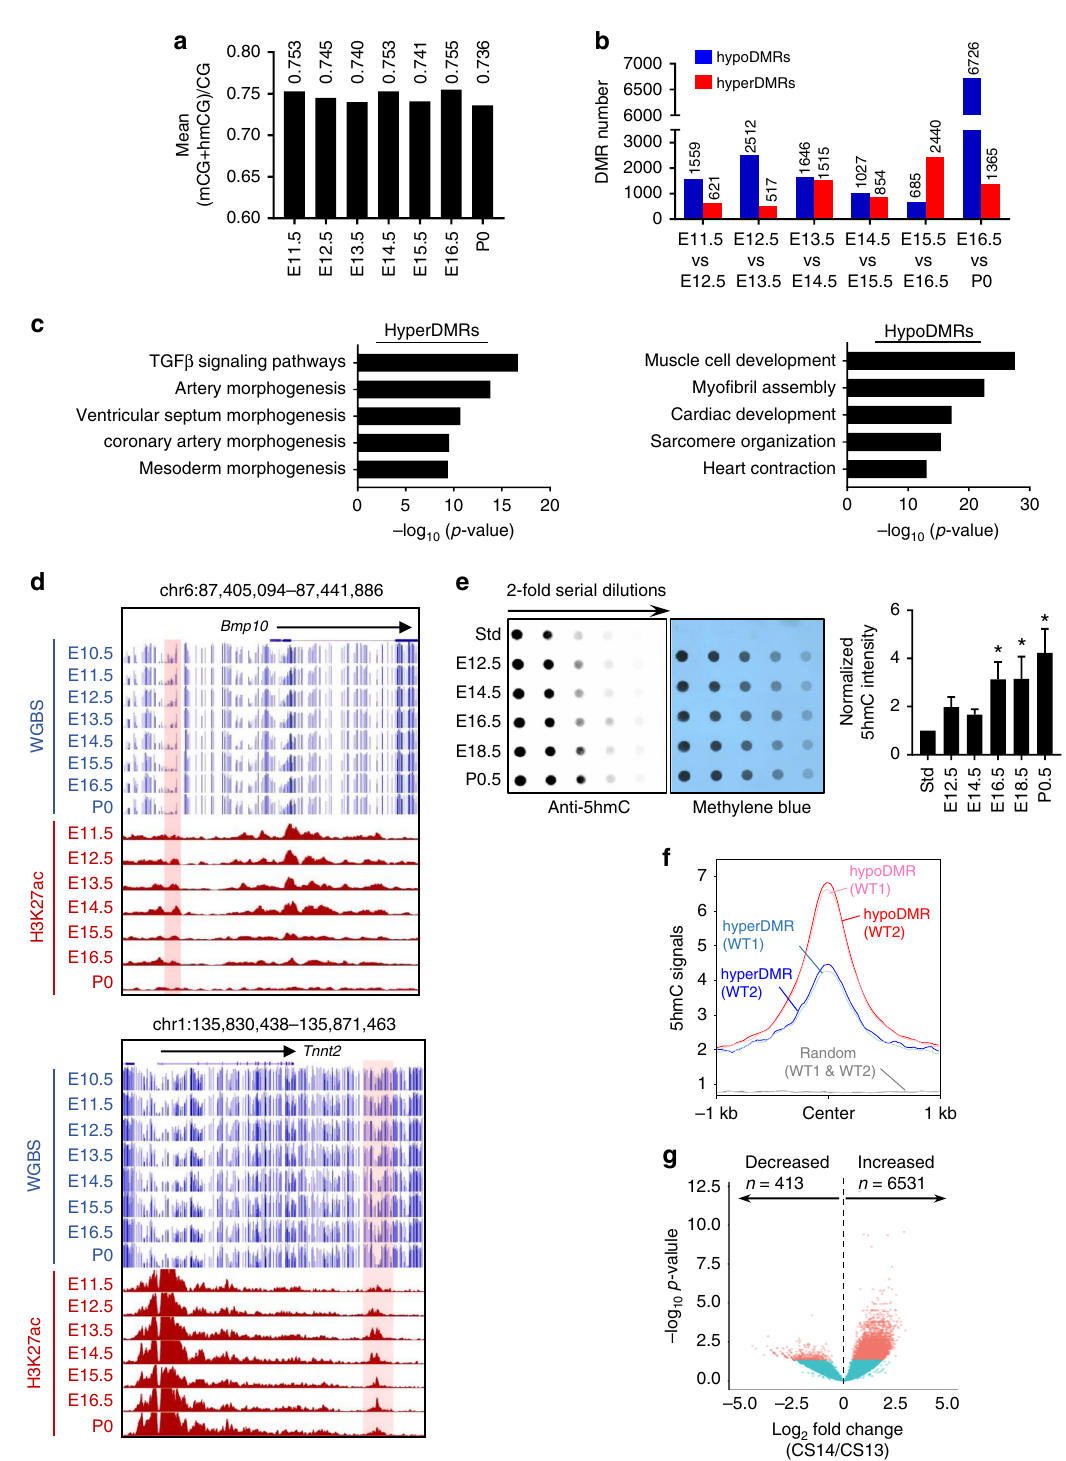
(hyperDMR de fi ned as DMRs with signi fi cant increase of 5mC signal when transitioning into the next developmental stage; Fig. 1f). We further analyzed DNA methylation and 5hmC enrichment in human embryonic heart tissues at CS13 and 14. CS14 transition (Fig. 1g, Supplementary Fig. 2A), coinciding with the strong induction of TET2 and TET3 expression at CS14 (Supplementary Fig. 1F). GREAT analysis implied that the genomic regions displaying signi fi cant differential DNA